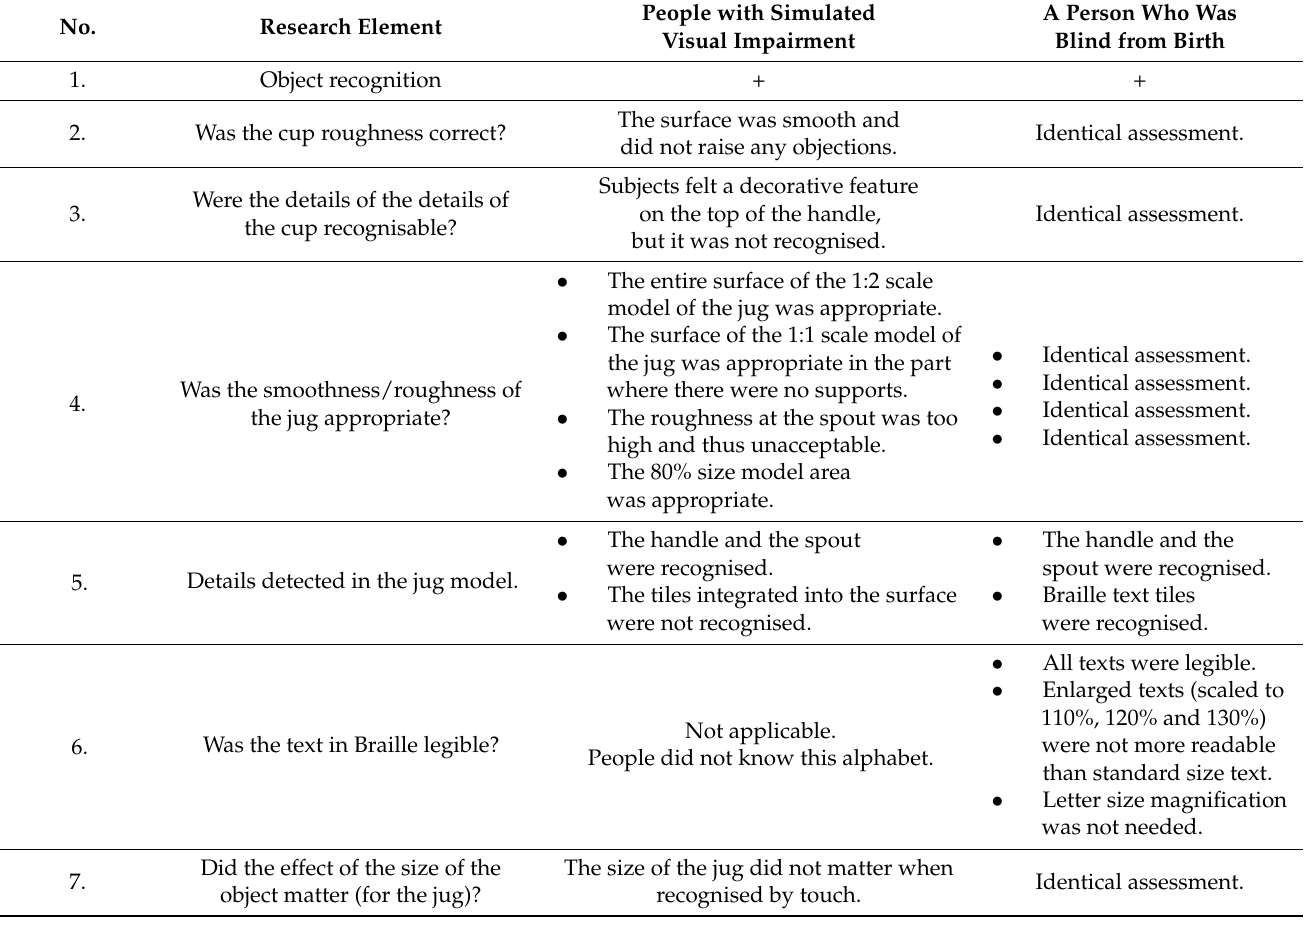
Table 3. Answers obtained to research